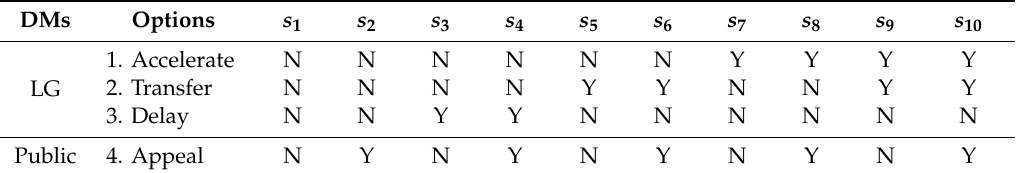
Table 2. Decision-makers (DMs), options, and feasible states in the brownfield conflict. LG — local government; Y — yes; N — no.